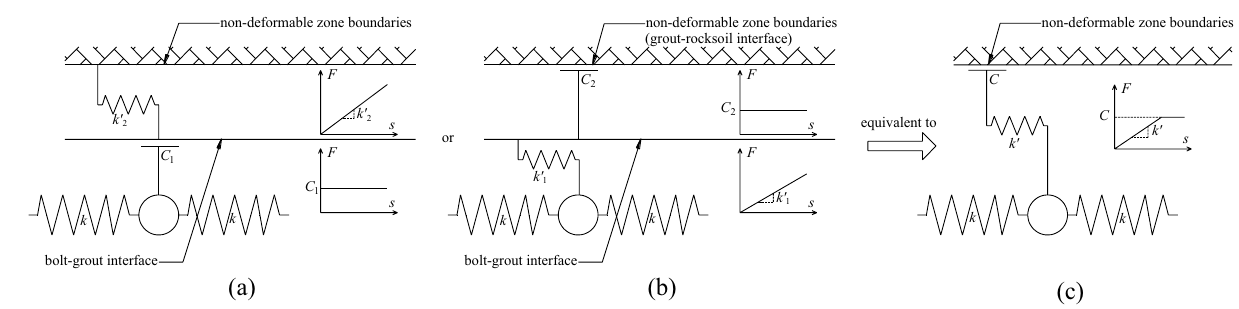
Figure 8. Evolution of the spring-pulled slider model. ( a ) When the bolt–grout interface is friction, and the grout–rocksoil interface is mechanical interlock; ( b ) When the bolt–grout interface is mechanical interlock, and the grout–rocksoil interface is friction; ( c ) The spring-pulled slider model.